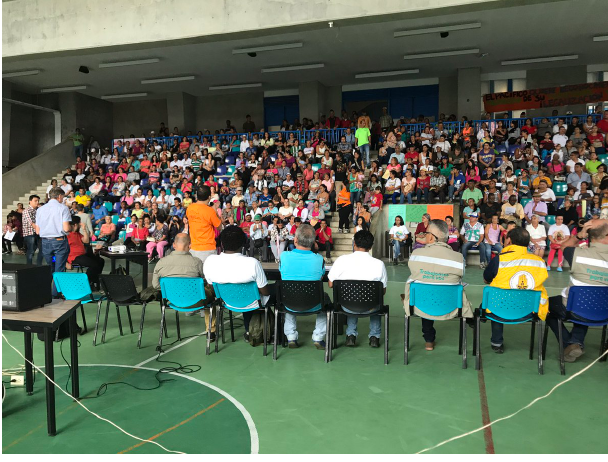
Fig. 5 . Cabildo Abierto in Comuna 8, 26 August 2017. Source: the